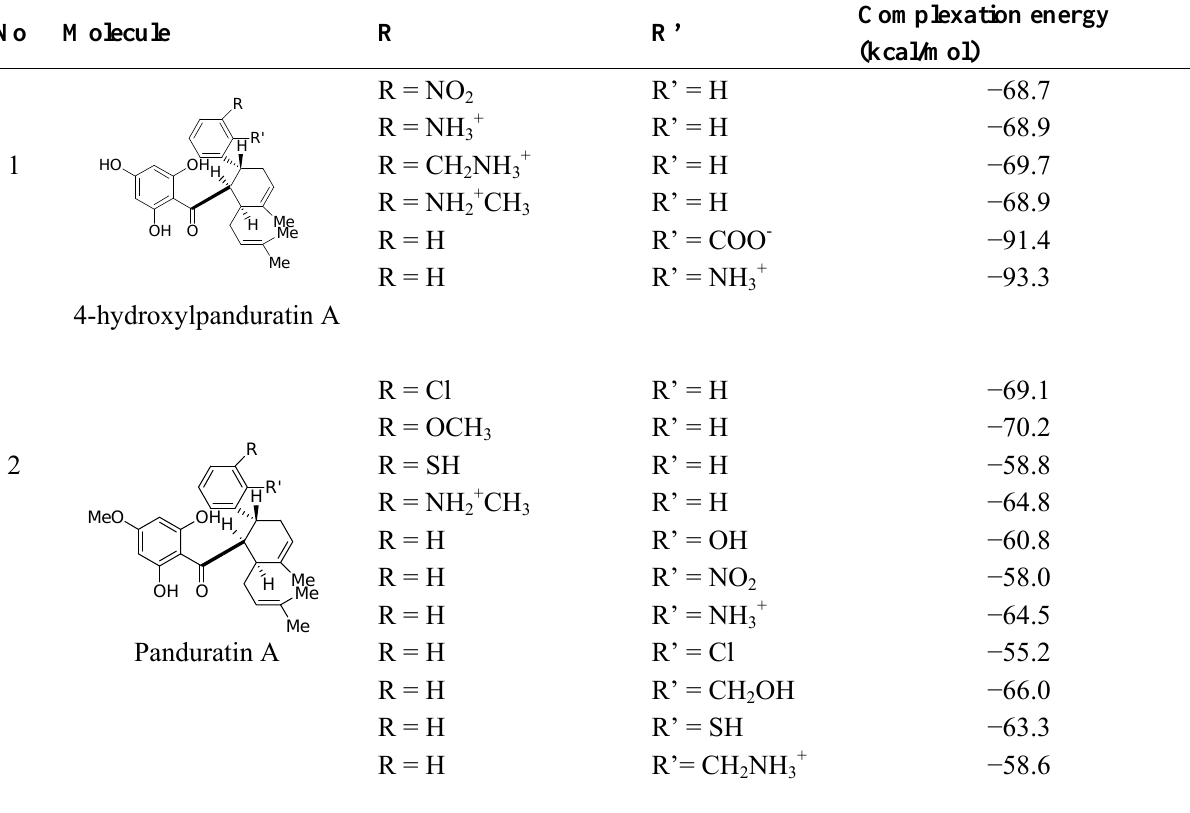
Table 3. Some 4-hydroxypanduratin A and panduratin A derivatives substituition at the 4 and 5 positions of the benzyl ring A (R and R’